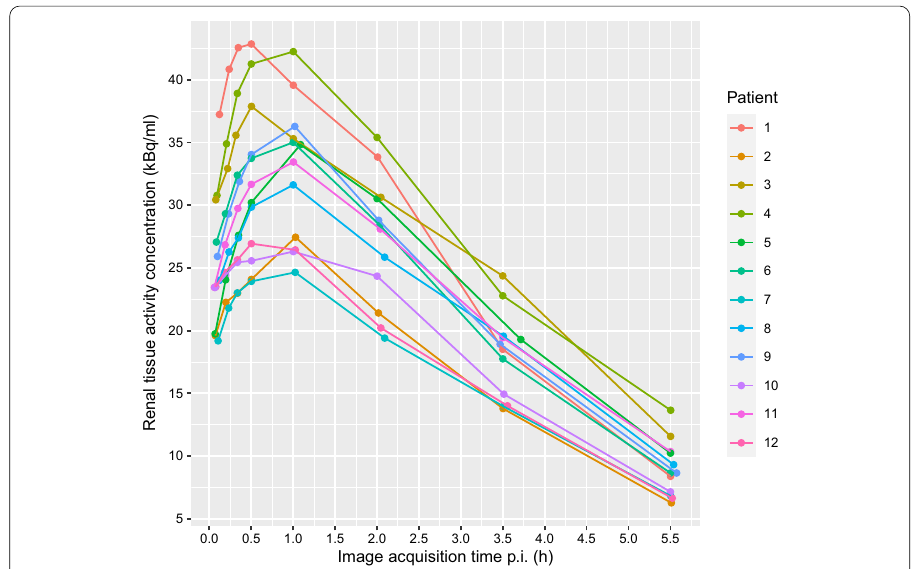
Fig. 1 Renal tissue activity concentration at different time points after 18 F-PSMA-1007 injection